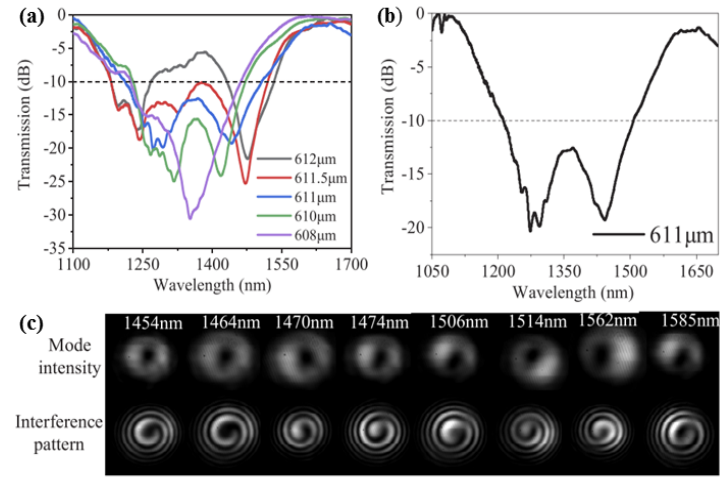
Figure 25. Measurement results for the HLPG-based ultra-broadband OAM mode converter. ( a ) Transmission spectra of the HLPGs with different pitches, ( b ) transmission spectra of the HLPG with a pitch of 611 μ m, ( c ) mode intensity distributions and the corresponding interference patters at different wavelengths. Adapted with permission from Ref. [93] © The Optical Society.